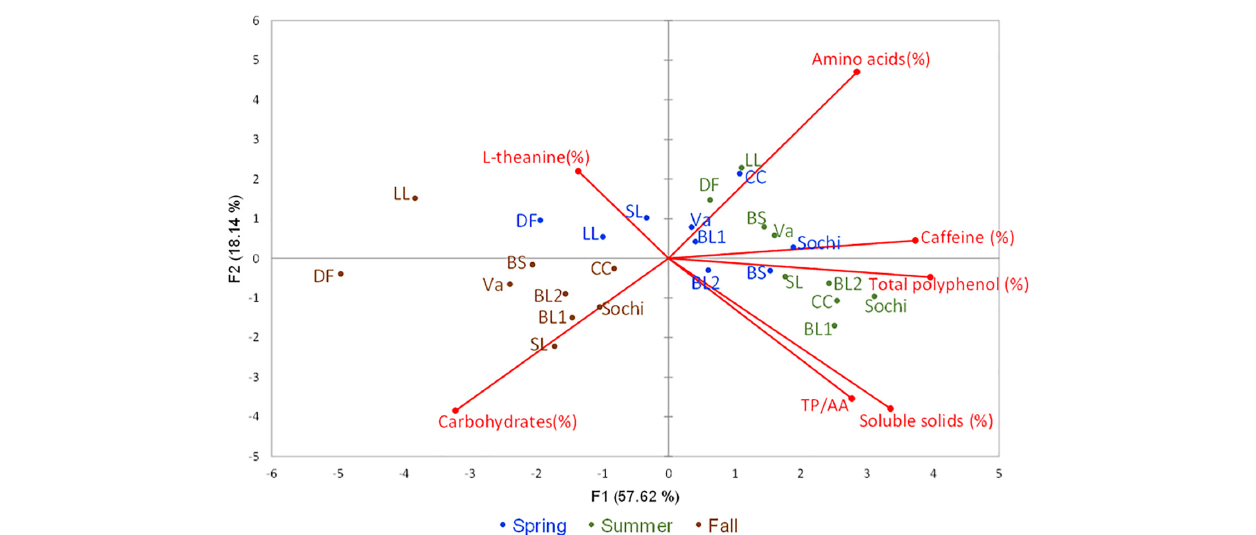
FIGURE 3 | Principle component analyses (PCA) in nine tea cultivars grown in Mississippi, United States with six descriptors. The principal components scatterplot was generated based seven descriptors including contents of soluble solids, carbohydrates, total polyphenols, caffeine, L -theanine, and the ratios between total polyphenols and free amino acids (TP/AA) using leaf samples collected from nine test tea and from three harvesting seasons from each cultivar in spring (blue color), summer (green color), and fall (brown color) of 2018. The first and second principal components accounted for 75.75% of the total variation. ‘BS’ stands for cultivar ‘Black Sea,’ ‘CC’ stands for cultivar ‘Christine’s Choice,’ ‘DF’ stands for cultivar ‘Dave’s Fave,’ ‘LL’ stands for cultivar ‘Large Leaf,’ ‘SL’ stands for cultivar ‘Small Leaf,’ ‘Va’ stands for cultivar ‘var. assamica